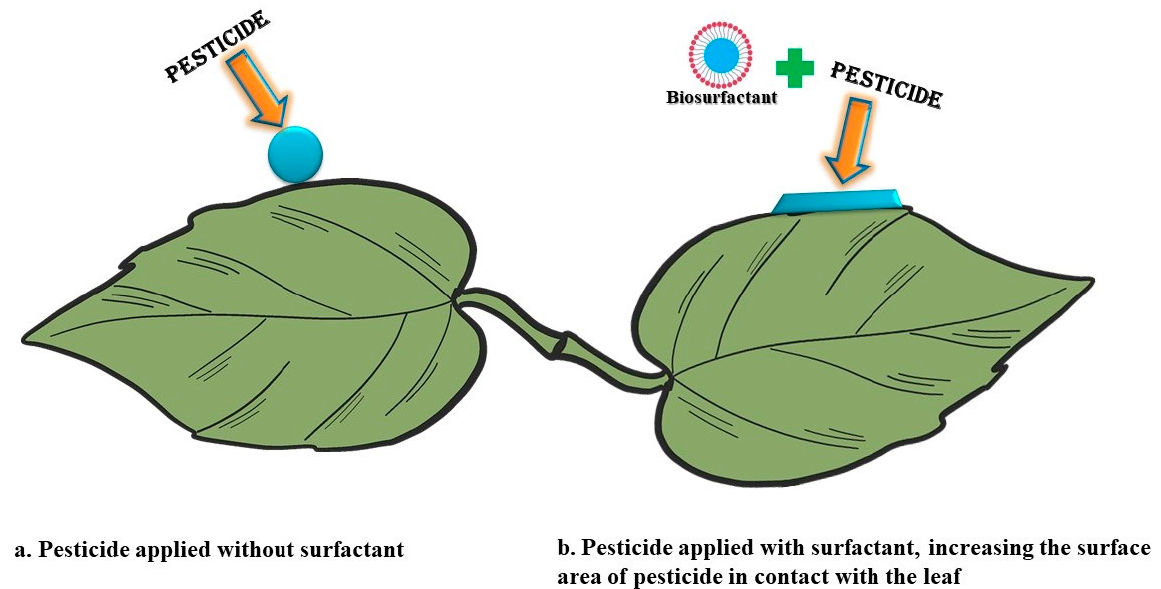
Figure 4. Depiction of the effect of surfactant on leaf surfaces. ( a ) Pesticide applied without surfactant; ( b ) pesticide applied with a surfactant, increasing the surface area of the pesticide in contact with the leaf. Figure adapted from Jibrin et al. [138].